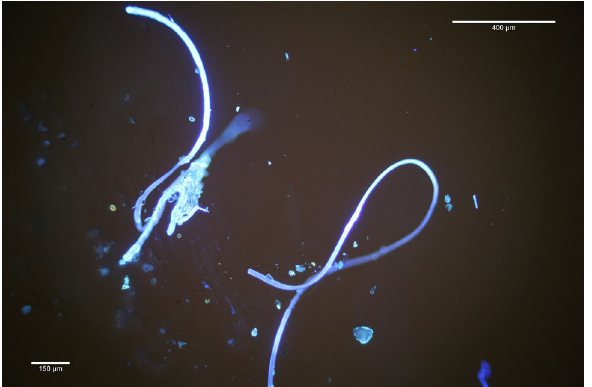
Figure 2. Microplastic fibres and particles under the microscope. Each of the filters collected was inspected and investigated under the microscope to quantify the amount of microplastic fibres and particles. Most polymers, the main structural molecular blocks of plastics, tend to shine under the ultraviolet light (UV-light), which was done using a BX53 Olympus